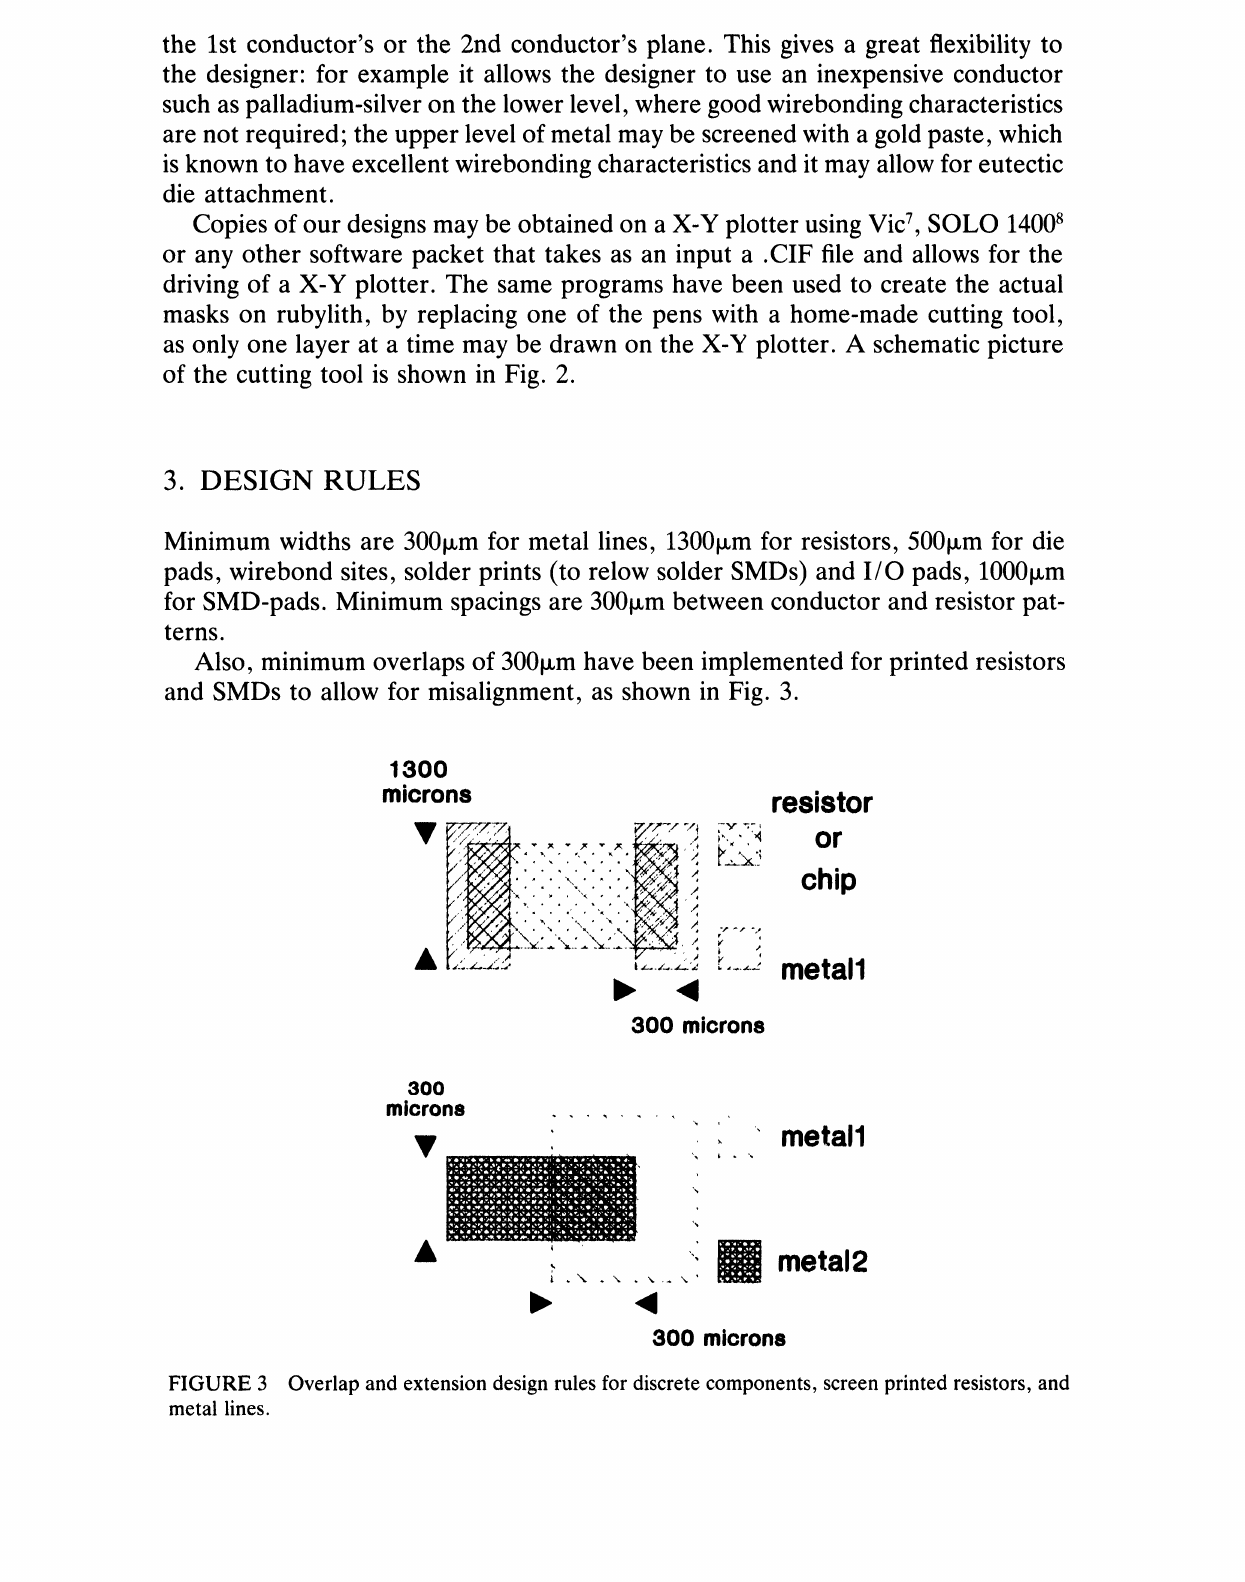
FIGURE 3 Overlap and extension design rules for discrete components, screen printed resistors, and metal